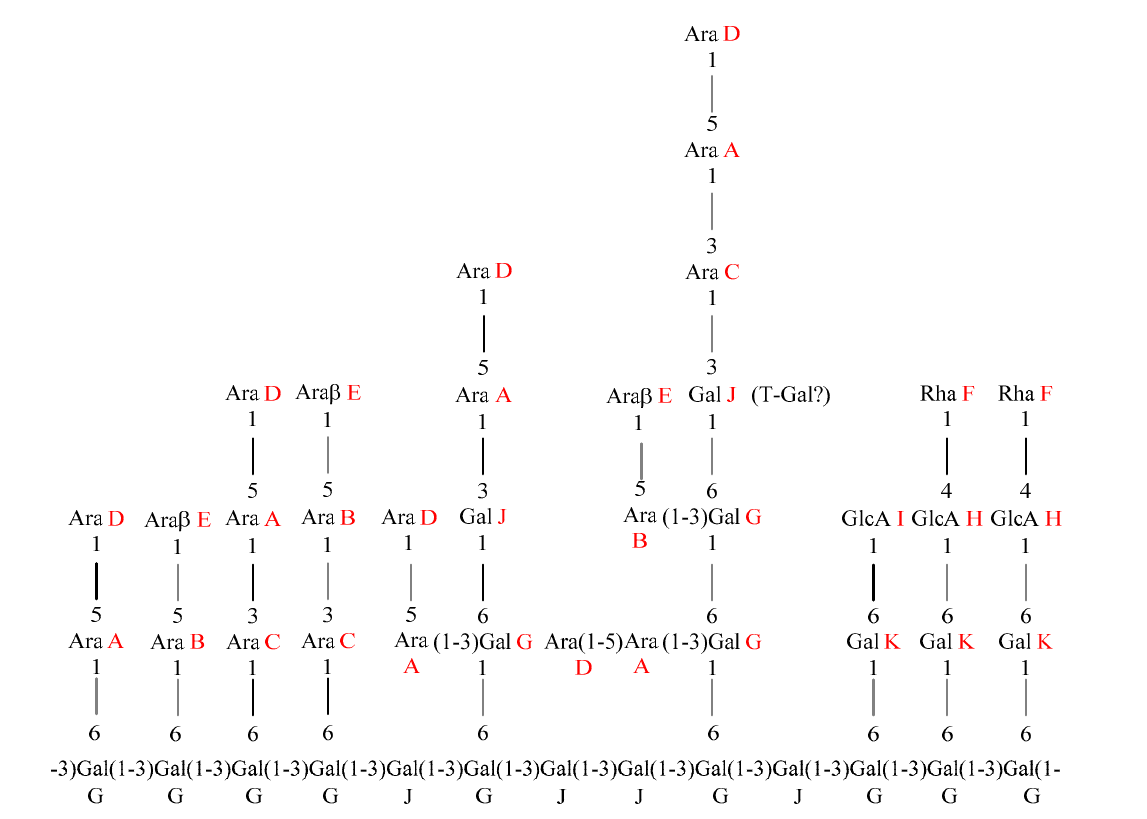
Figure 17. Hypothetical model of the structural features of the AGP glycan.